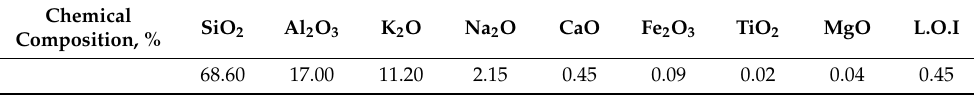
Table 4. Chemical composition of FK-100 potassium feldspar.